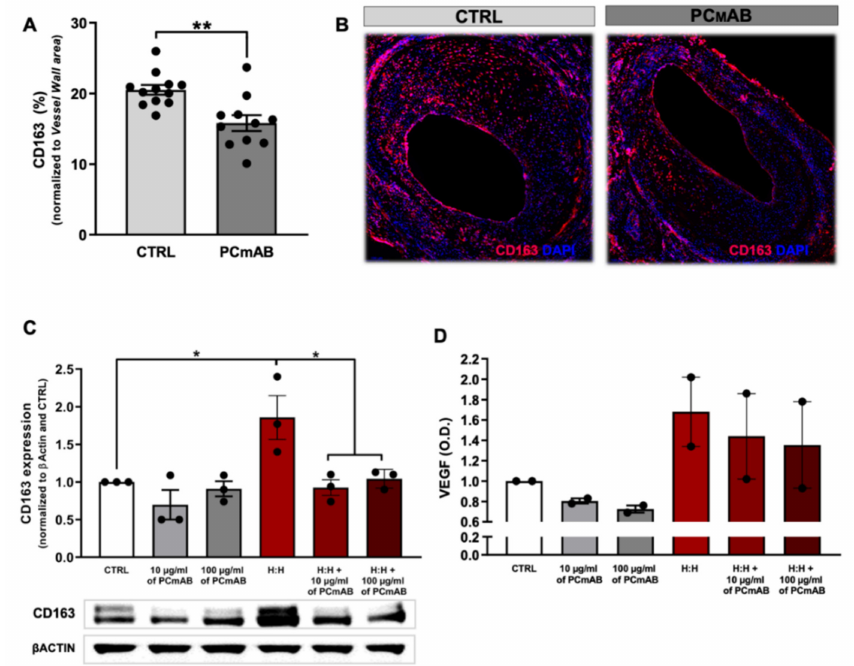
Figure 6. PC-mAb targets M(Hb) macrophages in vivo and in vitro by decreasing CD163 expression. Quantification of CD163 expression in VG lesions ( A ) and representative cross sections of CD163 (red) and DAPI (blue) staining of CTRL and PC-mAb group ( B ). Quantification of CD163 expression in THP- 1 cells treated with increasing doses of PC-mAb and with and without Hb:Hp (H:H) ( C ).Quantification of VEFG levels in THP-1 cell supernatant ( D ). Data presented as mean ± SEM. * p ≤ 0.05, ** p ≤ 0.01 by t -test and by 1-way